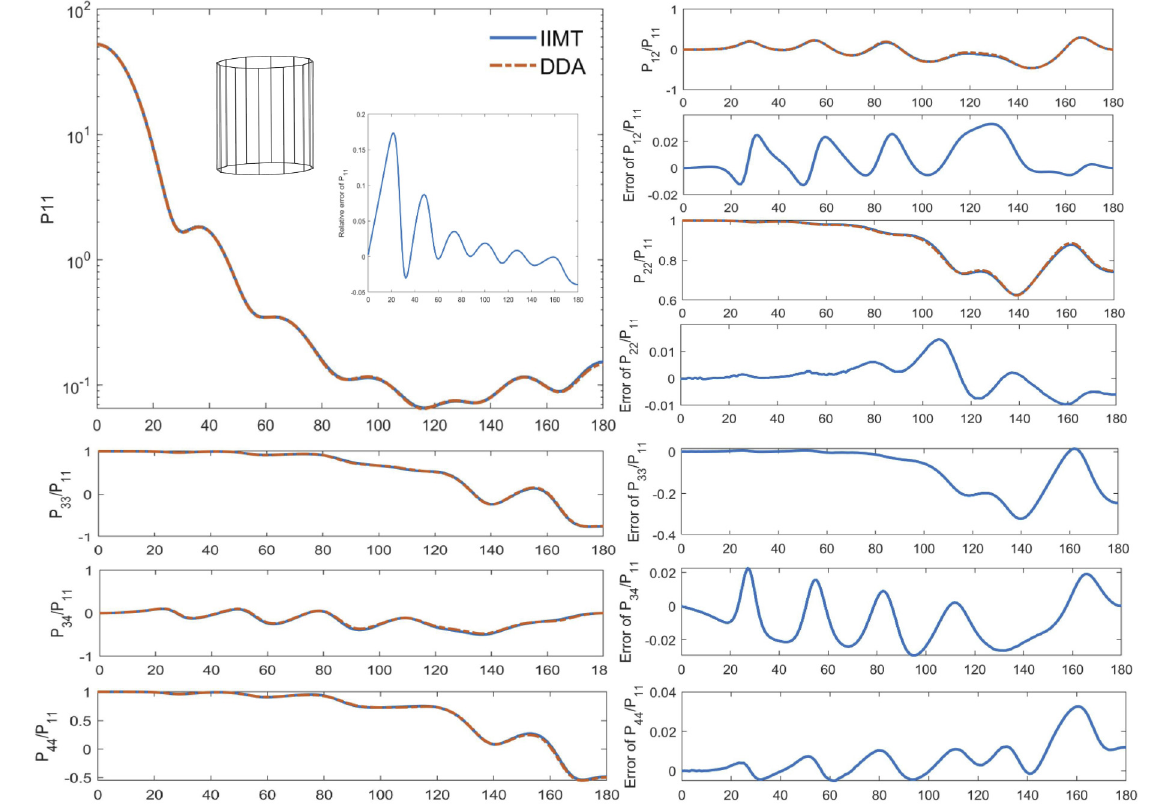
Figure 9. The phase matrices and their errors calculated by the IIM T − matrix and DDA methods for small twelve prism particles with random orientations. The abscissa is the scattering angle. The solid line is the IIM T − matrix model and the dashed is DDA model. The errors of P 12 /P 11 , P 22 /P 11 , P 33 /P 11 , P 34 /P 11 and P 44 /P 11 are absolute errors. (4)